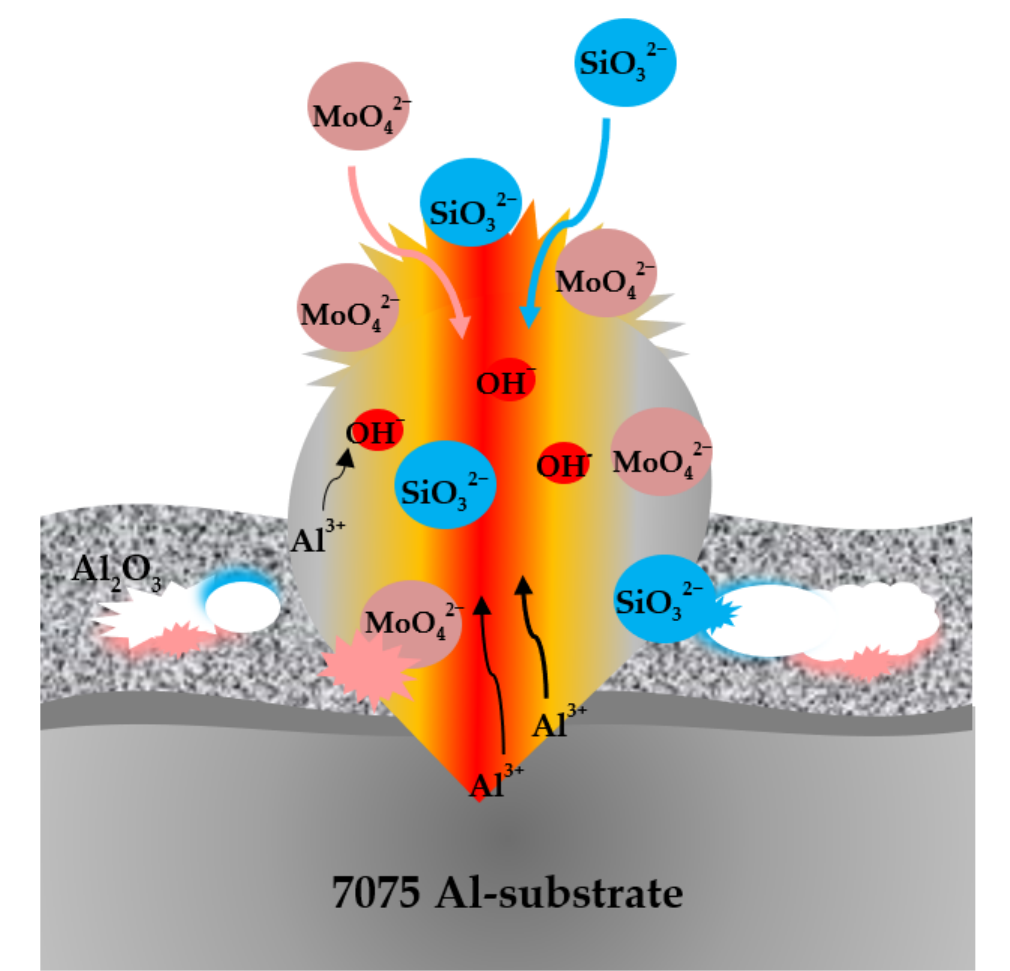
Figure 6. Schematic image from the incorporation of MoO 42 − and SiO 32 − anions in plasma discharging and the resulted structure of the